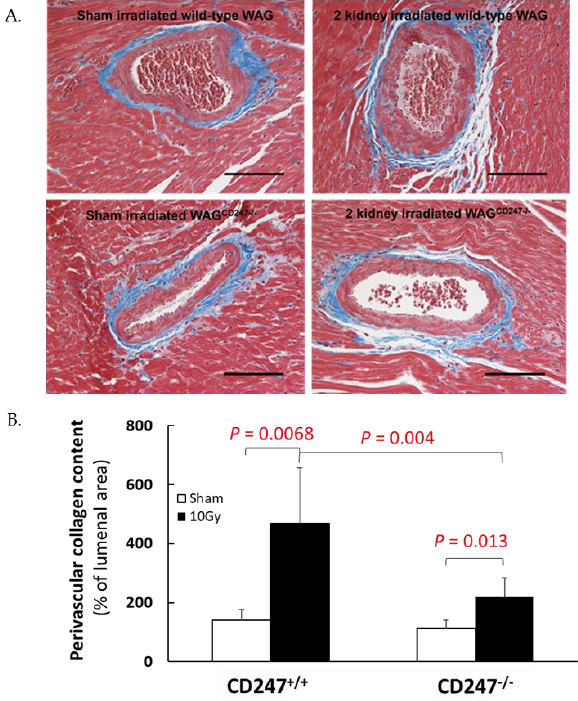
Figure 6. Collagen deposition in heart after local irradiation of kidneys with 10 Gy of X-rays in wild-type and WAG CD247-/- rats. ( A ) Trichrome staining of heart. The horizontal scale bar represents 100 microns. Images are representative data from 3–4 animals per group. ( B ). Quantification of perivascular cardiac collagen content in hearts of wild type and WAG CD247-/- rats 120 days after the start of the study. Data are mean + SD, n = 6/group. 3.6. Early Radiation Nephropathy Is Not Associated with Engagement of Immune Cells To determine whether early radiation nephropathy, evident on day 40 by elevated BUN levels, is linked to engagement of the immune system and the induction of fibrosis, IHC and histology was carried out on kidney tissues from wild-type WAG and WAG CD247- /- rats after sham-irradiation or irradiation with 10 Gy. There was no increase in CD3 + , CD56 + , CD68 + or CD20 + positive cells in the kidneys after irradiation in wild-type WAG rats and WAG CD247-/- rats compared with sham-irradiated controls (Figure 7).